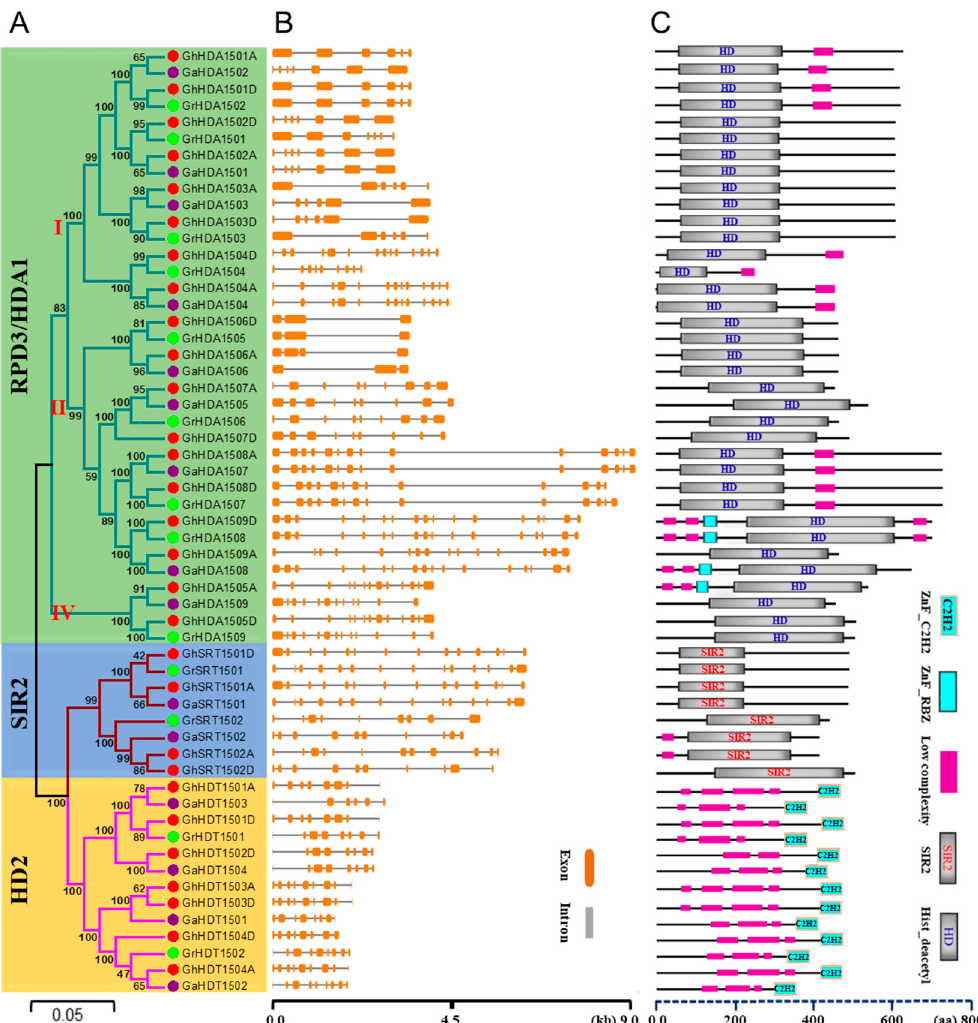
Figure 2. Phylogenetic relationships, gene structure analysis, and domain organization of HDACs in G. hirsutum , G. raimondii and G. arboretum . ( A ) The unrooted phylogenetic tree was constructed with MEGA 6 using the neighbor-joining method and the bootstrap analysis was performed with 1000 replicates. The HDACs from G. hirsutum , G. raimondii , and G. arboretum are marked with red, green, and purple dots, respectively. The branches of each subgroup are indicated in a specific color. ( B ) The intron-exon structure of HDACs from G. hirsutum , G. raimondii and G. arboretum . Orange boxes and grey lines represent exons and introns, respectively. ( C ) Domain organization of HDACs from G. hirsutum , G. raimondii and G. arboretum .